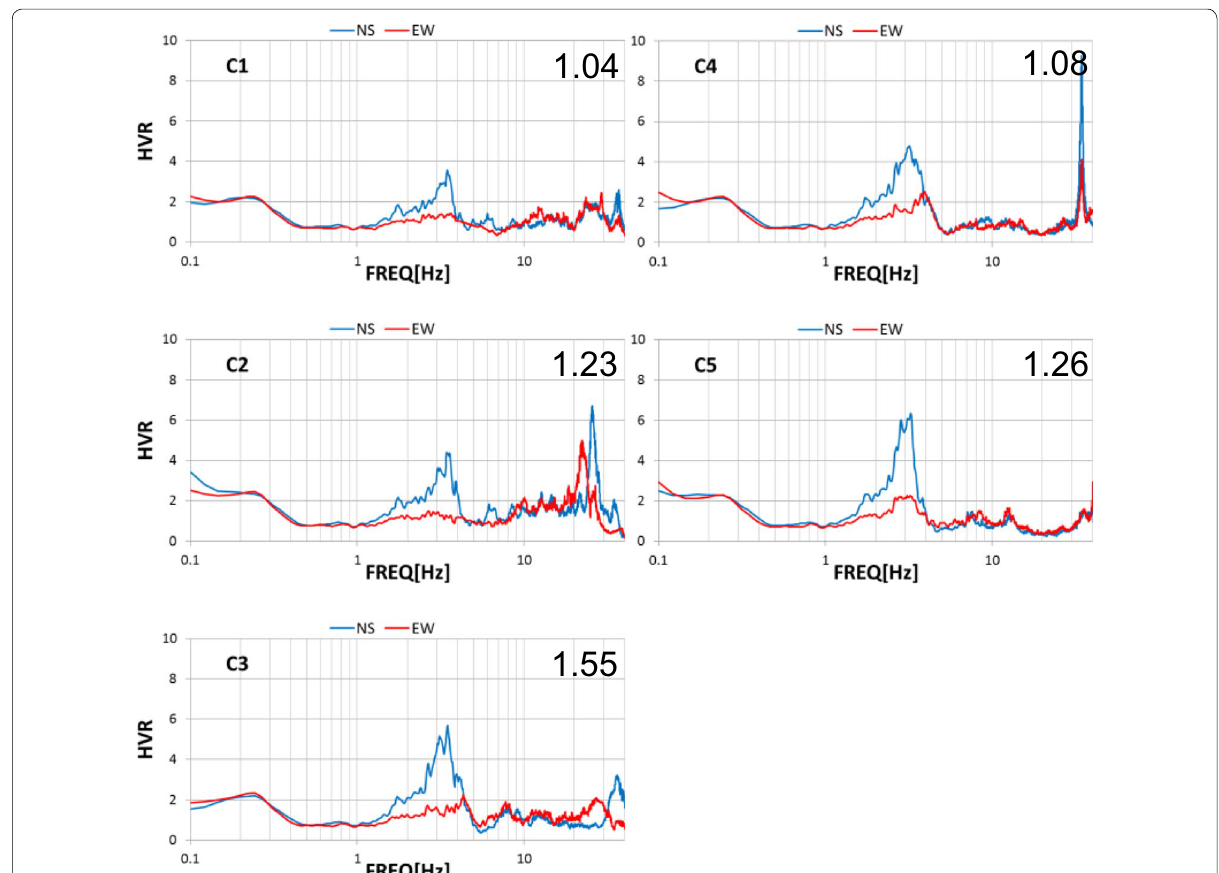
Fig. 7 Comparison of MHVRs along Line-C shown in Fig. 3. The figures from top-left to bottom-right are aligned from west to east on the survey line. Red and blue lines indicate NS/UD and EW/UD. The difference between the two is significant at all points. The value of γ for each point is denoted in the right-top